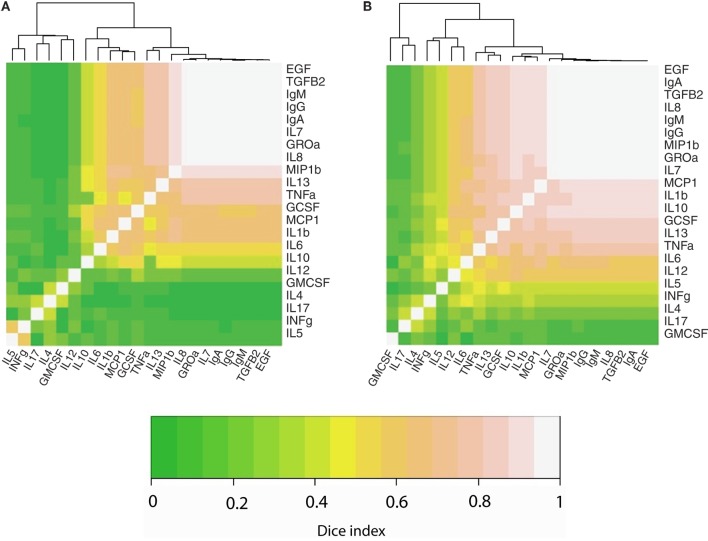
Heatmaps representing the co-occurrence frequency among immune factors analyzed in human milk, as determined per Sorensen–dice index in developed (A) and developing (B) countries. Lighter colors indicate strongest co-occurrence frequency.